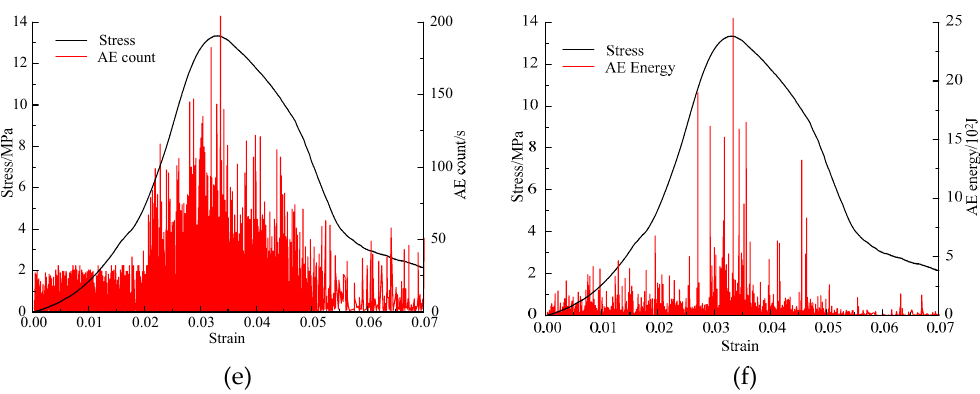
Figure 4. Stress–strain–acoustic emission (AE) curves of mortar specimen Groups A3, B3 and C3. ( a , c,e ) are stress–strain–AE count curves of mortar specimen Groups A3, B3 and C3, respectively; ( b , d , f ) are stress–strain–AE energy curves of mortar specimen Groups A3, B3 and C3, respectively.